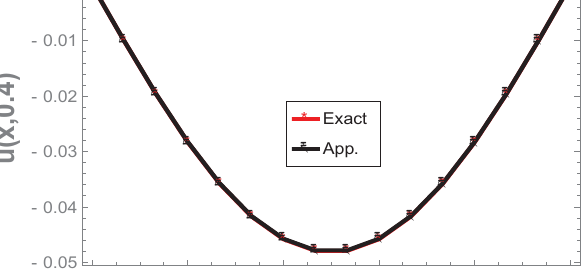
Figure 8: Absolute error y = 0.5